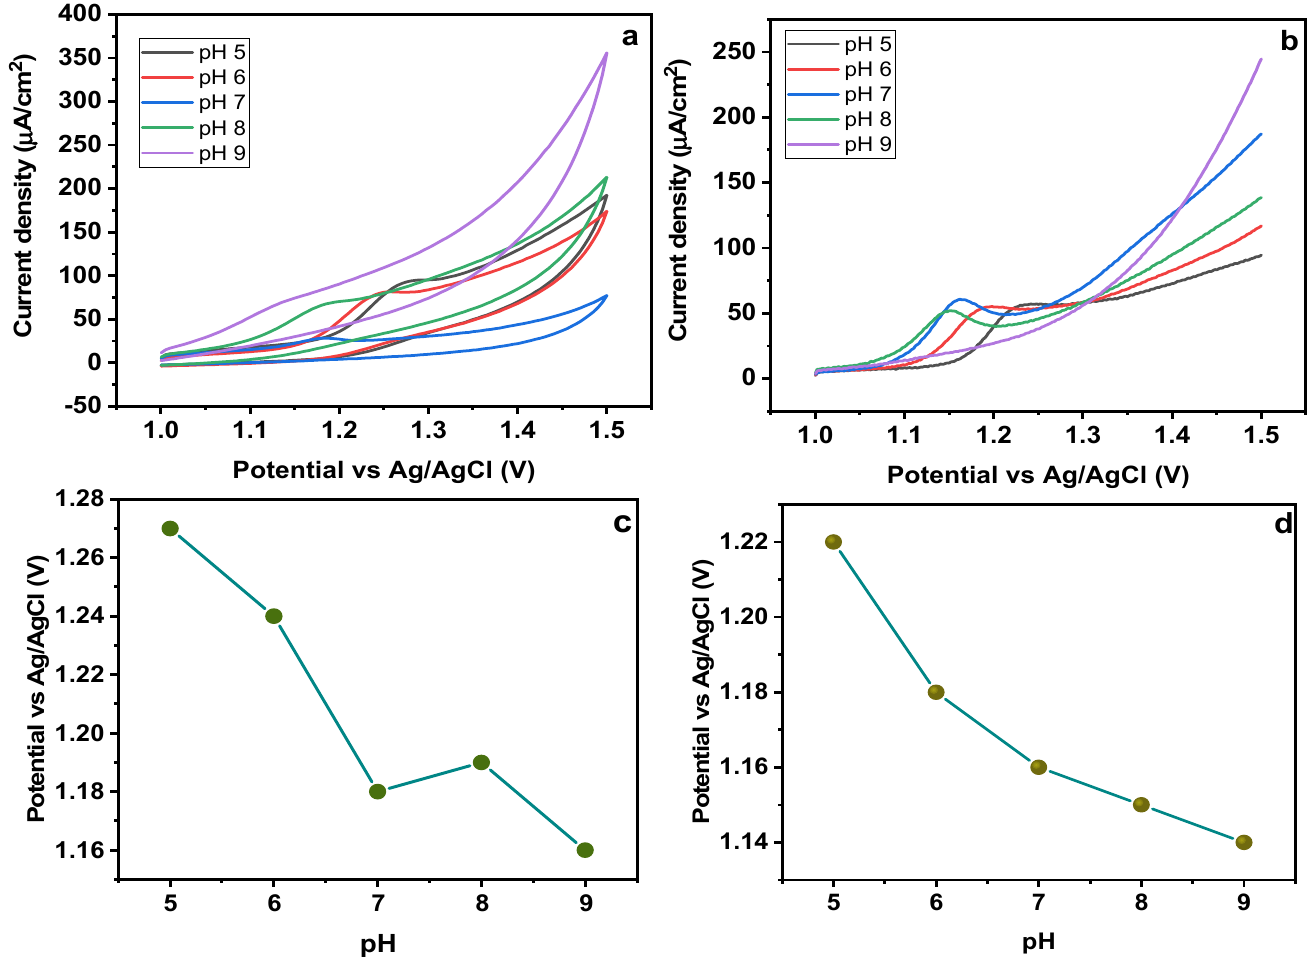
Figure 9. Effect of pH on ( a ) CV and ( b ) SWAdASV for Fe 3 O 4 @MIP/CPE sensors ( c ) pH vs peak potential for CV ( d ) pH vs peak potential for SWAdASV. (scan rate = 50 mV/s).